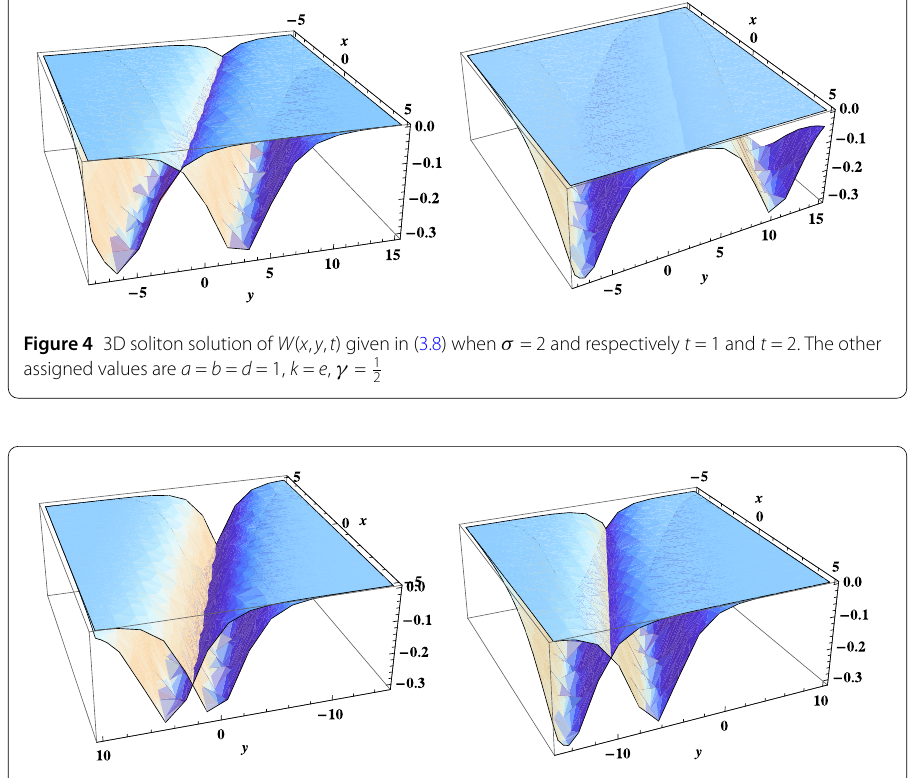
Figure 5 3D soliton solution of W ( x , y , t ) given in (3.8) when σ = –2 and respectively t = 1 and t = 2. The other assigned values are a = b = d = 1, k = e , γ = 1